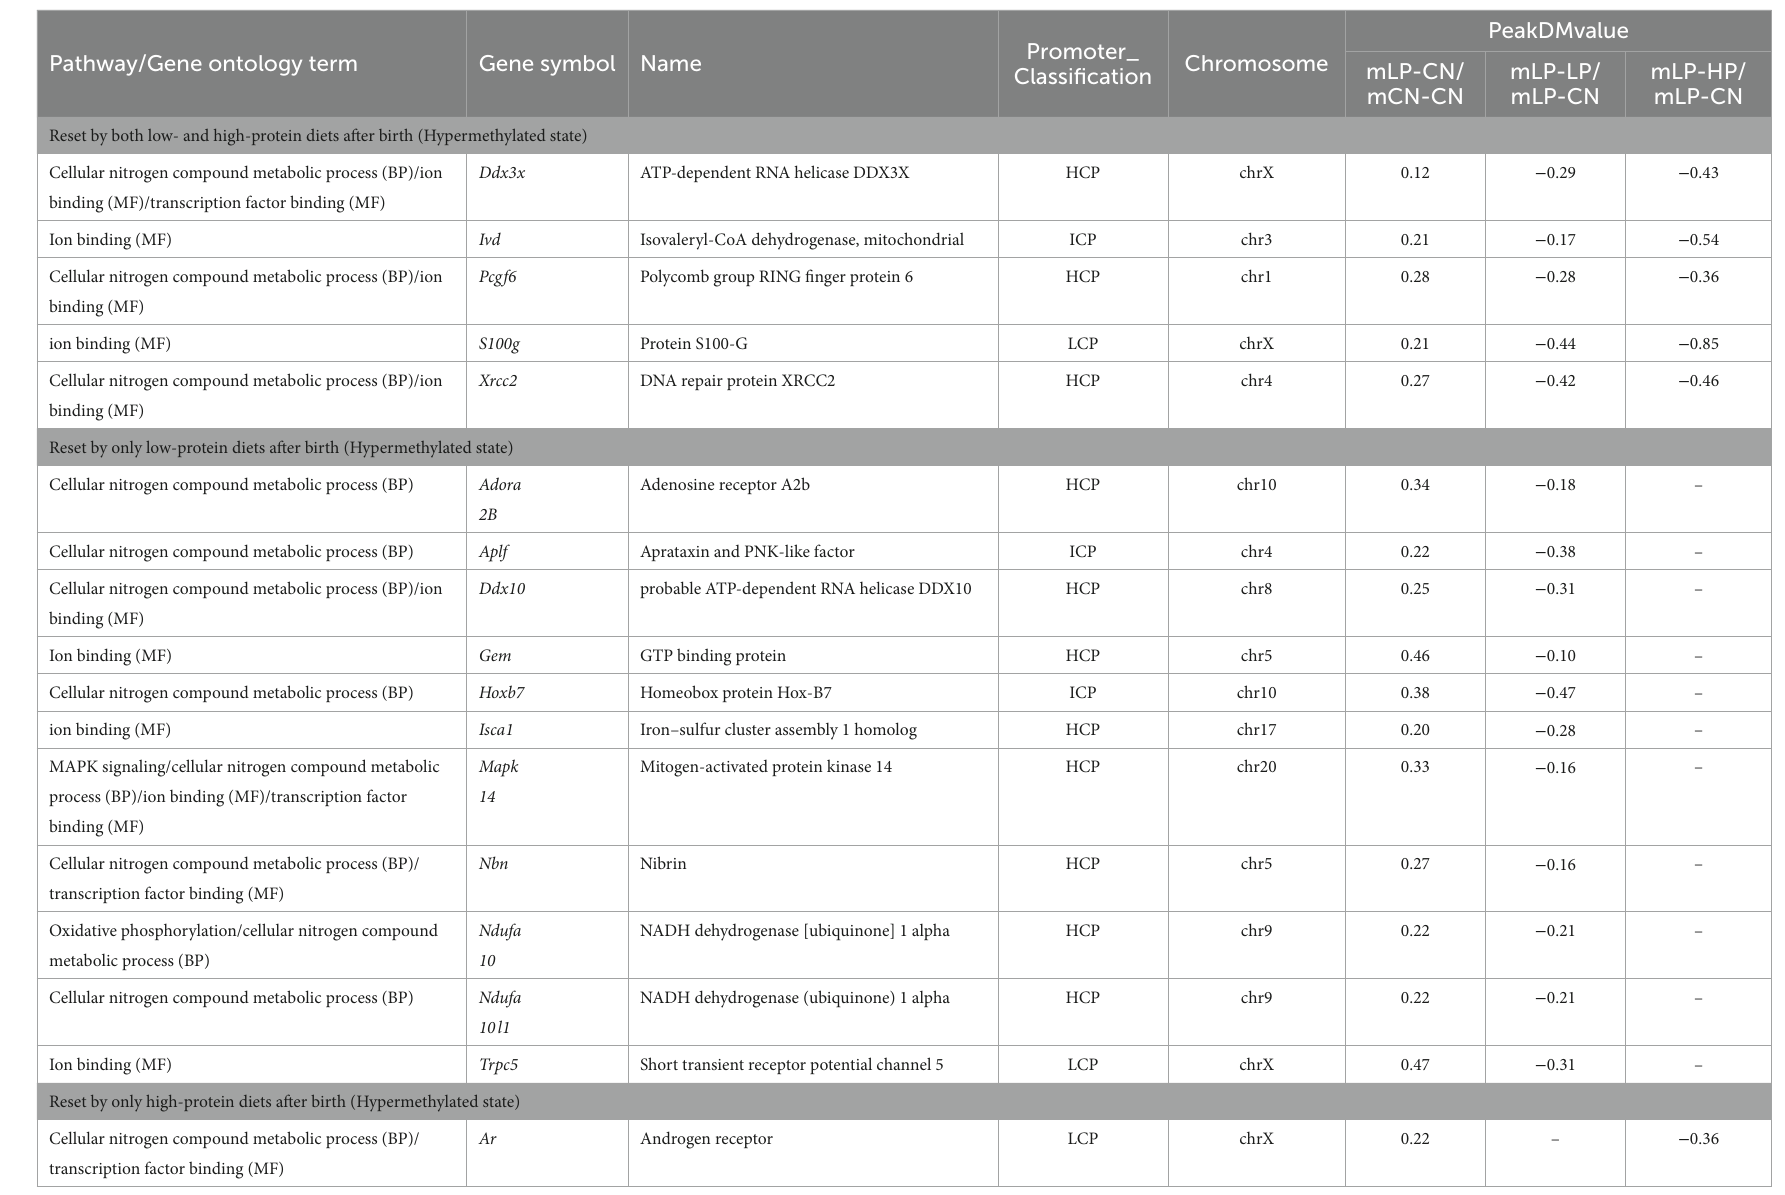
TABLE 2 DNA methylation status in the kidney for genes that were altered to a hyper- or hypo-methylated state due to low maternal protein intake and reset by differences in dietary protein intake after birth.